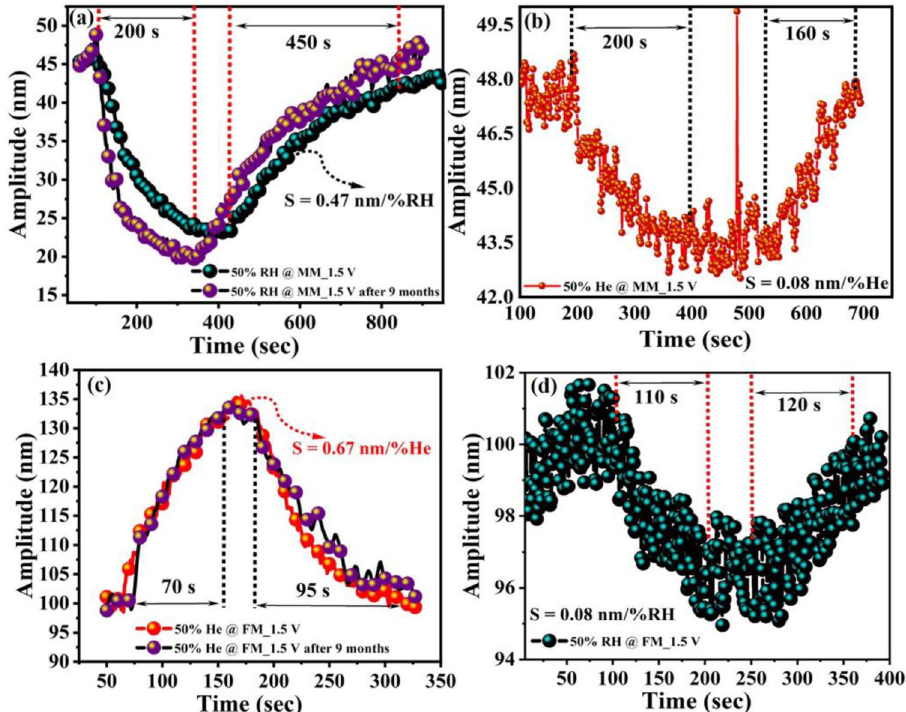
Figure 7. Sensing results of the individually actuated vibration modes, ( a ) responses to 50% relative humidity before and after nine months at mass mode operated at f o1 = 30.67 kHz, ( b ) response to 50% He at mass mode (MM) operated at f o1 = 30.67 kHz, ( c ) responses to 50% He before and after nine months operated at flexural mode operated at f o3 = 162.95 kHz, and ( d ) responses 50% relative humidity at flexural mode (FM) operated at f o3 = 162.95